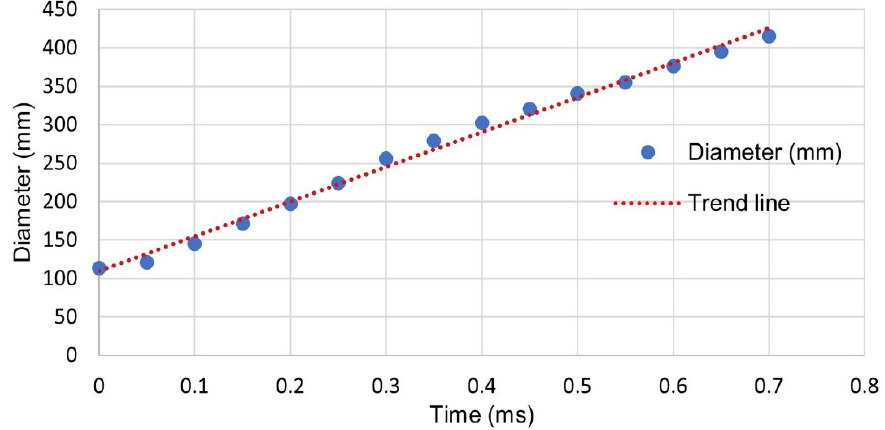
Figure 10. Changes over time in the diameter of deformed projectile during impact.